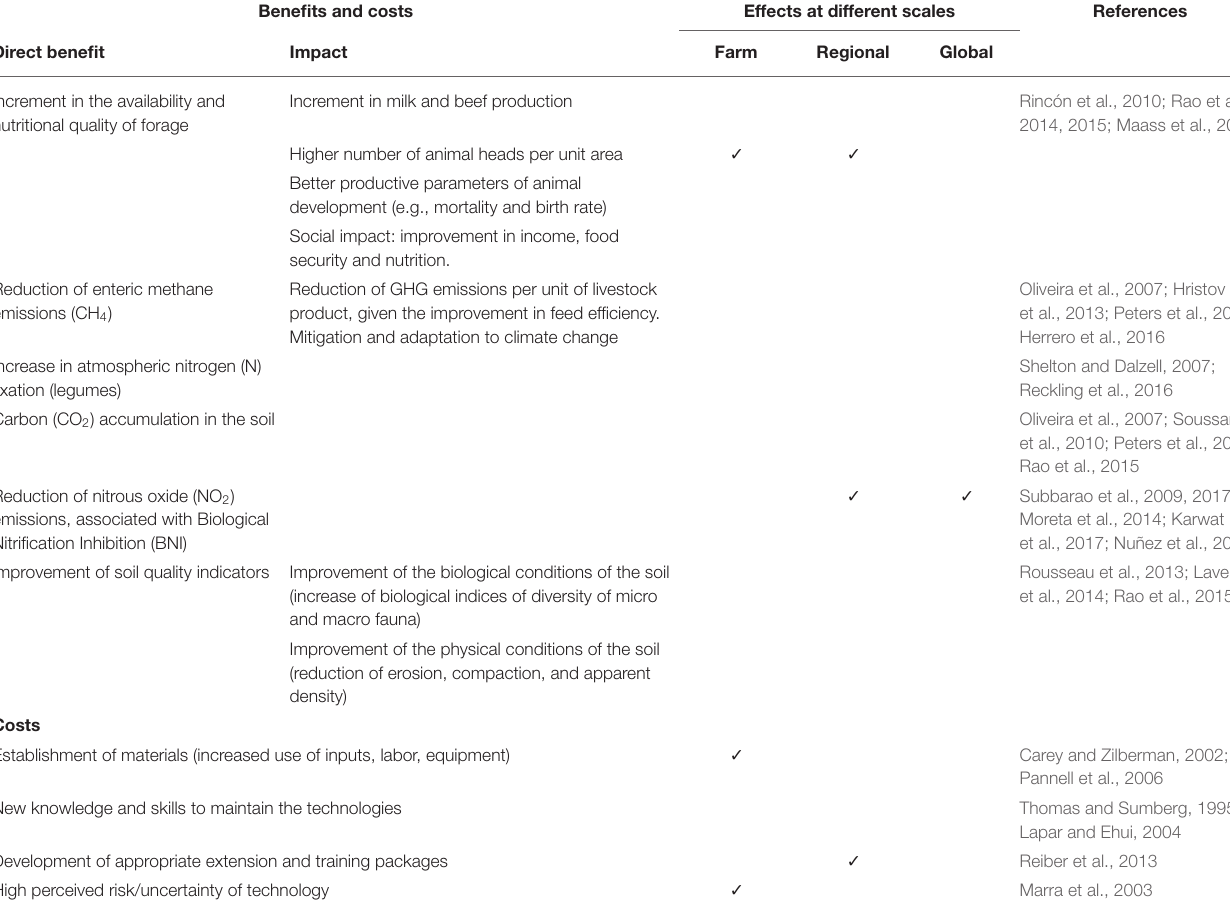
TABLE 2 | Benefits and costs of improved